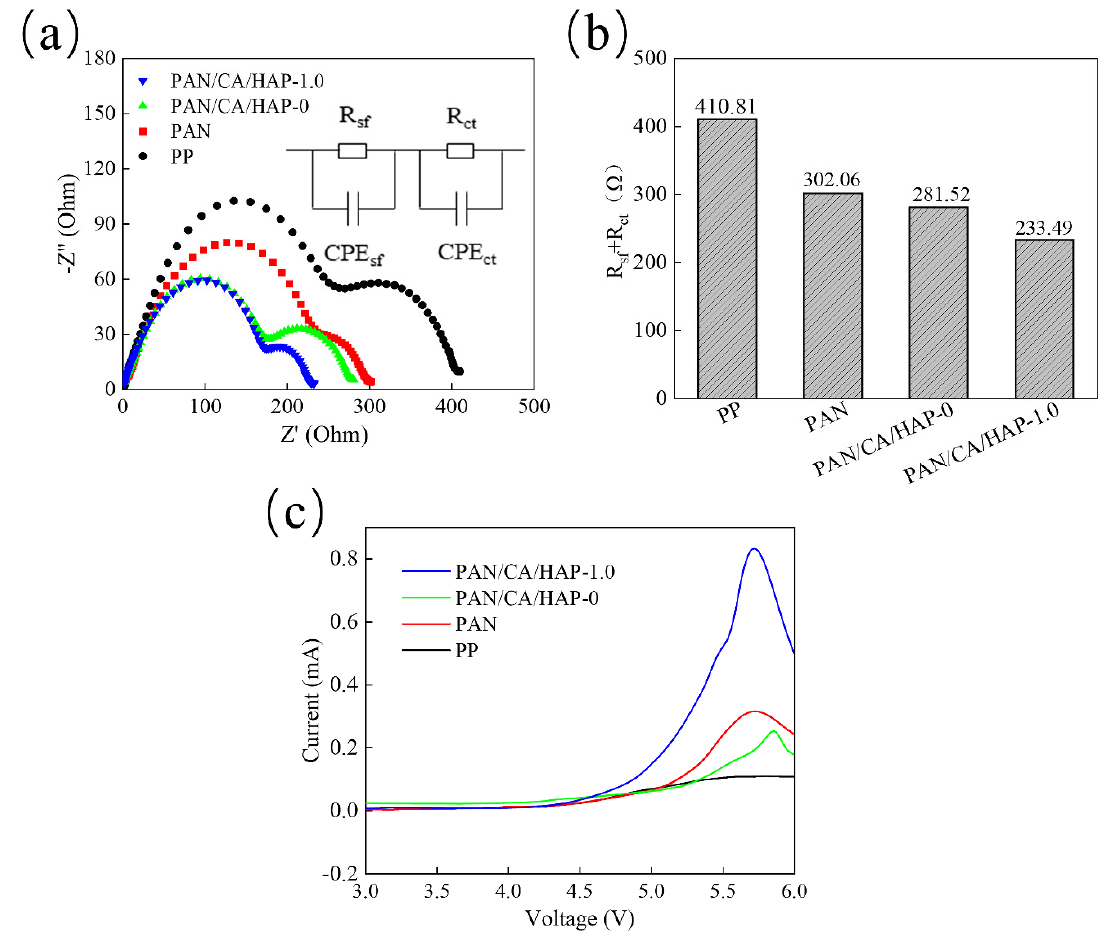
Figure 9. ( a ) Interfacial AC impedance spectra and equivalent circuit; ( b ) The sum of Rsf + Rct; ( c ) Linear scan voltammo–grams (LSV) curve. ( c ) Linear scan voltammo–grams (LSV)